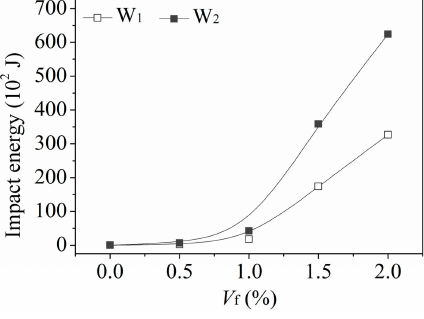
Figure 7. Influence of V f on impact energy.